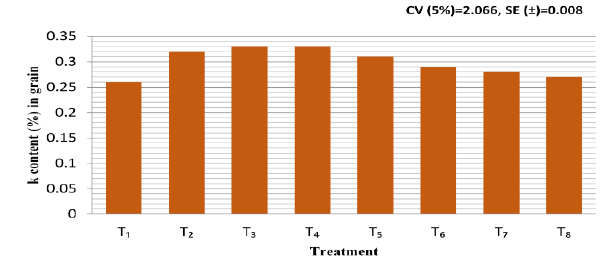
Figure 1: Potassium content (%) in rice grain of BRRI dhan49 as influenced by Banana leaves and chemical fertilizers.